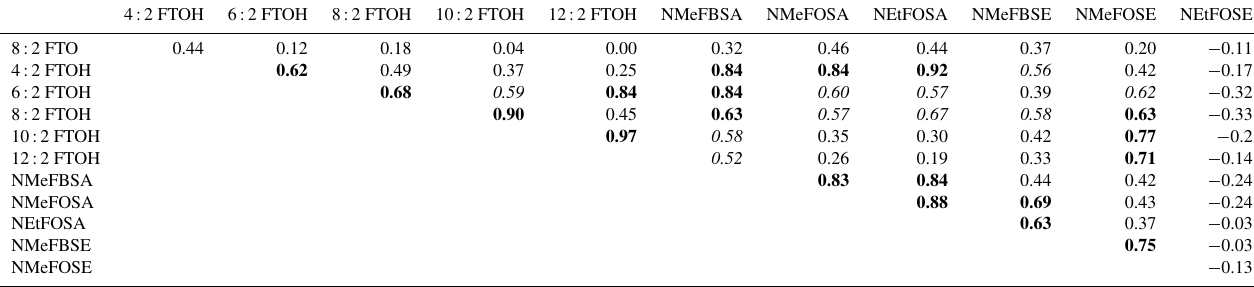
Table 2. Correlation ( r ) of individual compounds among all the